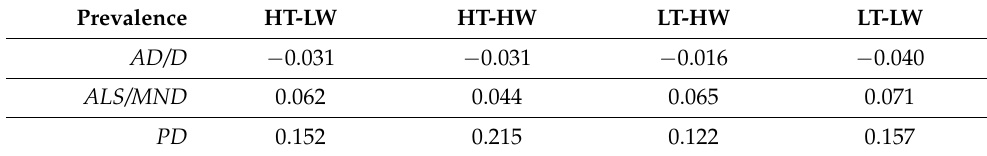
Table 1. Prevalence median values 1990–2016 variation for AD/D, ALS/MND and PD